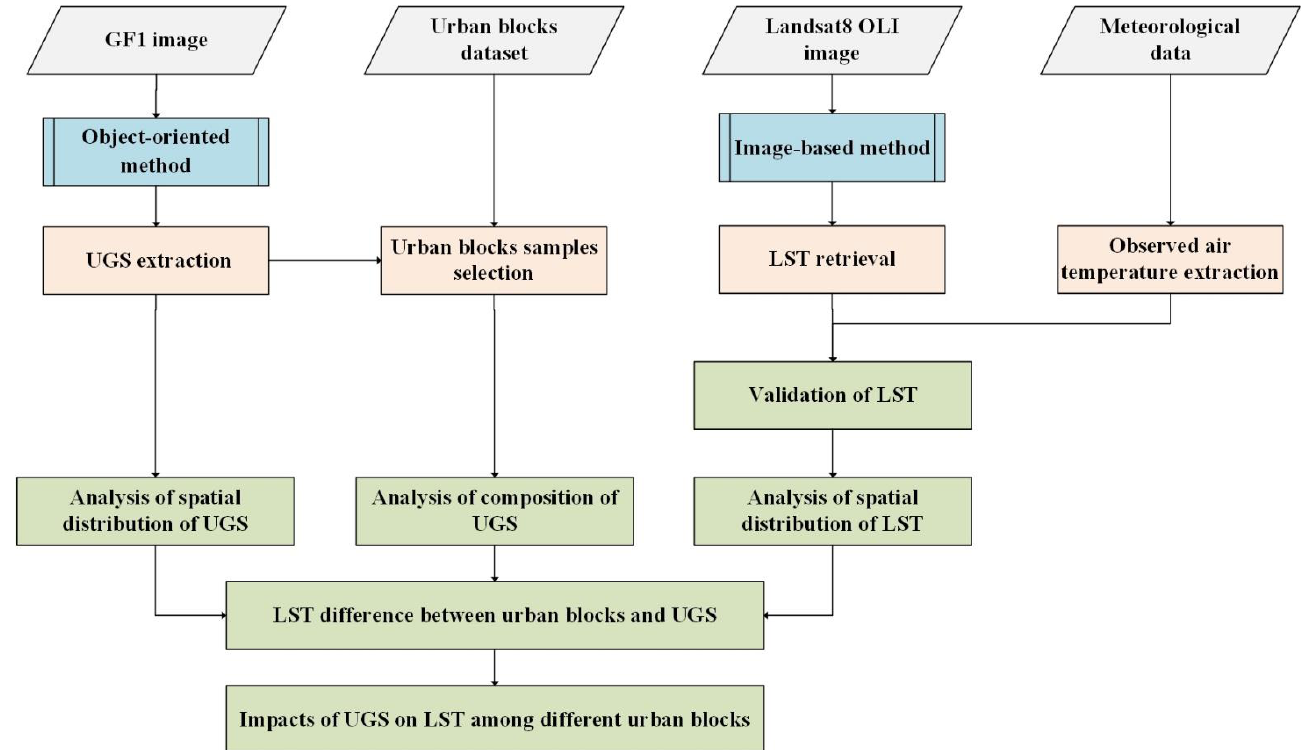
Figure 2. Flowchart of this study.